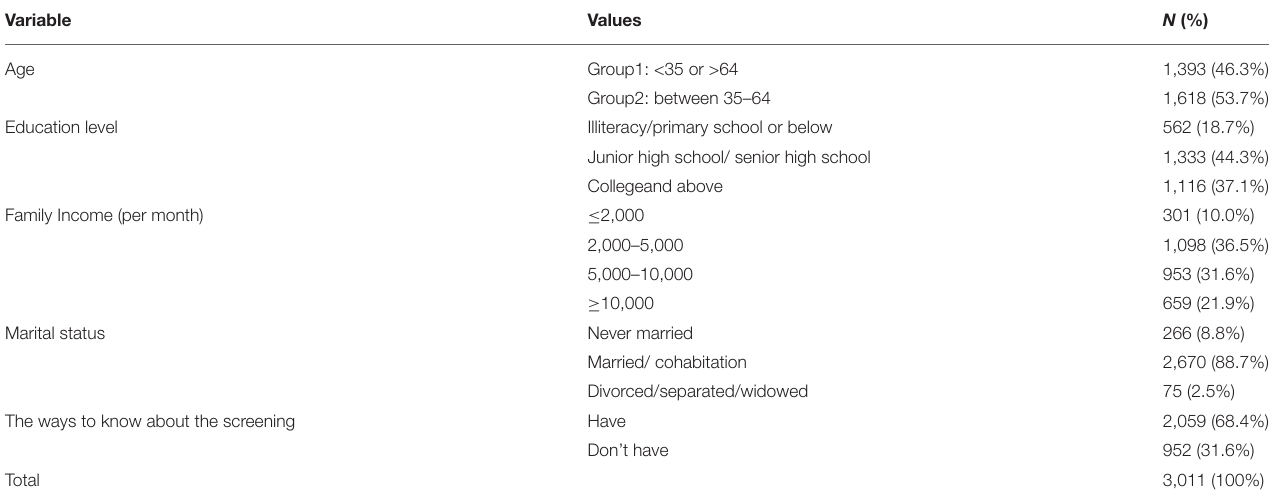
TABLE 1 | Participant demographics and characteristics ( n = 3,011).